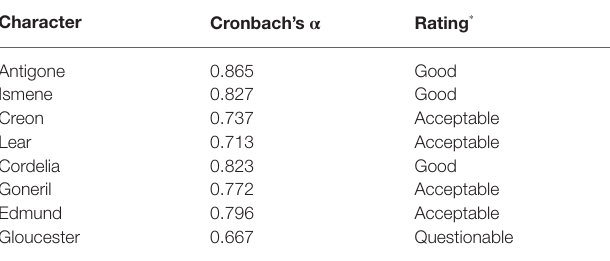
TABLE 3 | Cronbach’s alpha scores on summed responses to the five identification questions across participants for the eight main characters in the two